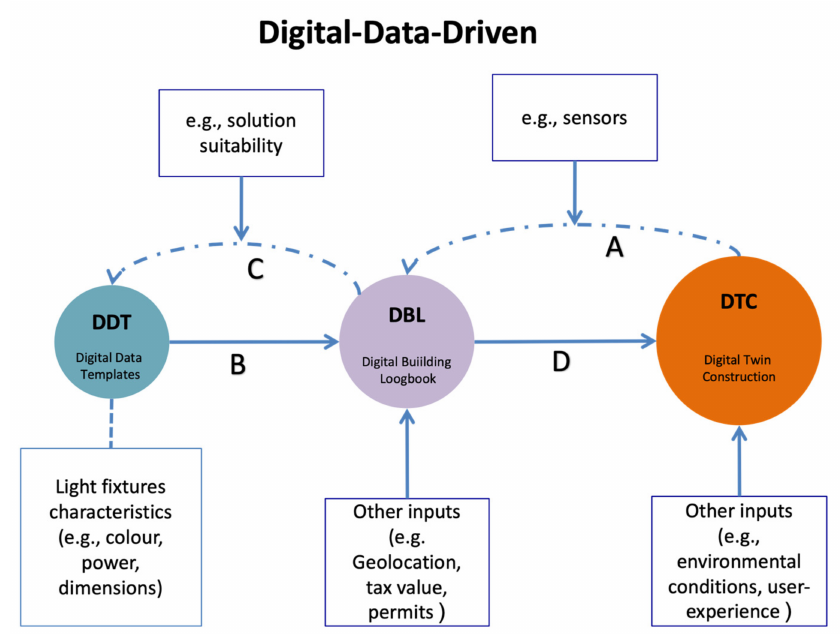
Figure 4. DDT, DBL, and DTC enabling a digital data-driven concept—D3c